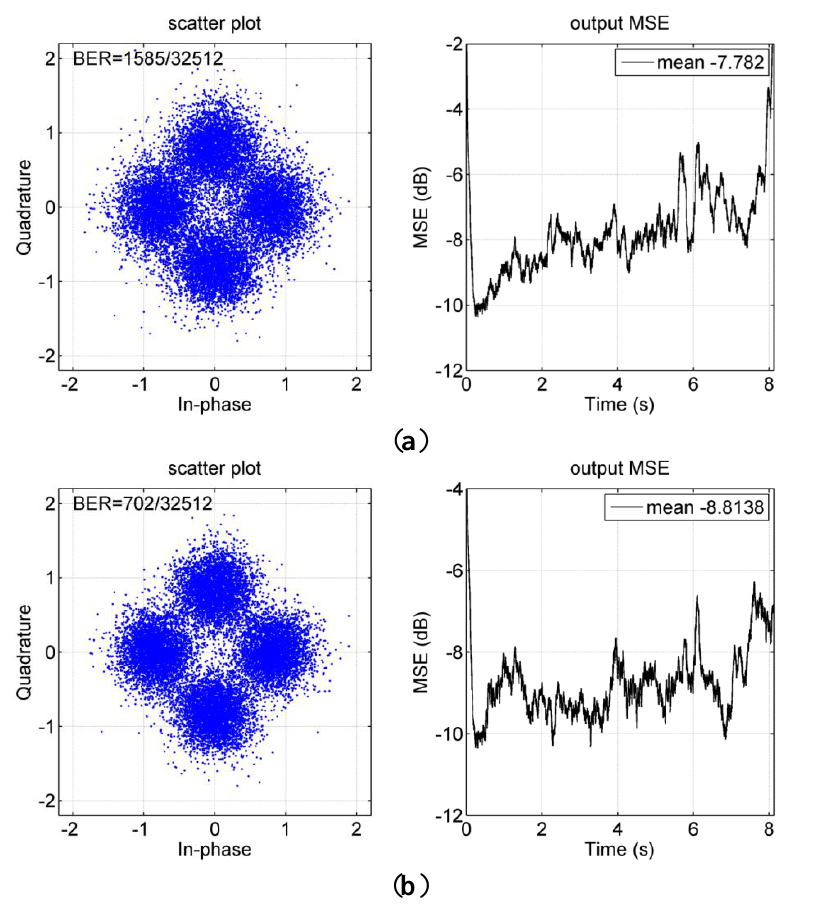
Figure 14. Performance of PPC-DFE with different approaches. ( a ) One block; ( b ) 9 blocks. The MP algorithm is used, and the symbol rate is 2 kilo-symbol/s.